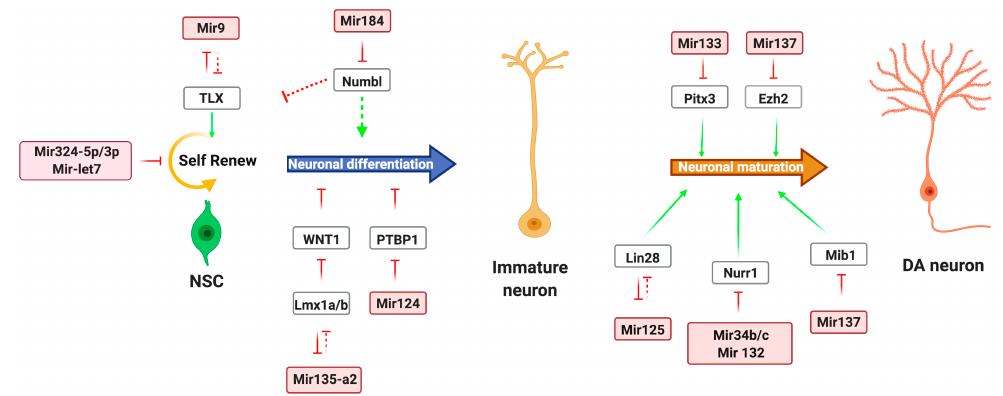
Figure 1. miRNA network involved in DA neuron development. Representative miRNAs involved in the control of self-renewal and proliferation from the neural stem cell (NSC) stage towards dopamine (DA) neuron differentiation. Red arrow-heads or flat-heads indicate positive or negative direct modulation of the indicated genes, respectively. Green arrows indicate overall modulation of a biological process. Dashed lines indicate hypothetical direct or indirect modulation. miRNAs are highlighted by colored boxes.